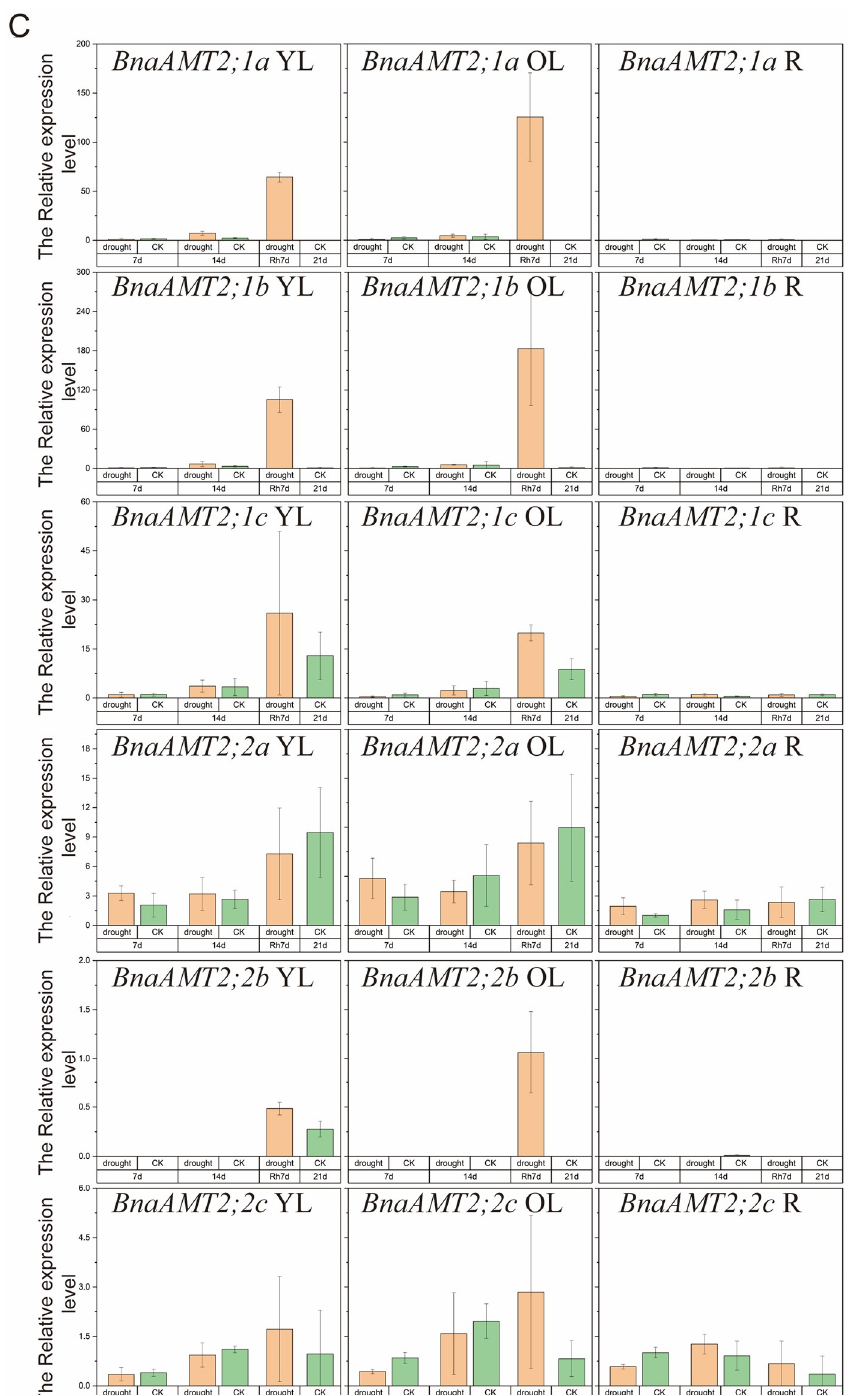
Figure 6. Expression profiles of BnaAMT family genes responding to drought stress. ( A ) The relative expression level of BnaAMT1;1a - BnaAMT1;2b ; ( B ) the relative expression level of BnaAMT1;3a - BnaAMT1;4b ; ( C ) the relative expression level of BnaAMT2;1a - BnaAMT2;2c . YL, young leaf; OL, older leaf; R, root; CK, control; drought, drought stress treatment; 7d, 7th day of drought stress; 14d, 14th day of drought stress; Rh7d, 7th day after rehydration; 21d, 21st day of drought stress. Rapeseed seedlings at the five-leaf growth stage were subjected to drought stress for 14 days before rehydration. The relative expression levels of BnaAMTs were relative to the control ( actin 7 ). Four biological replicates were performed. Error bars represent standard deviation.